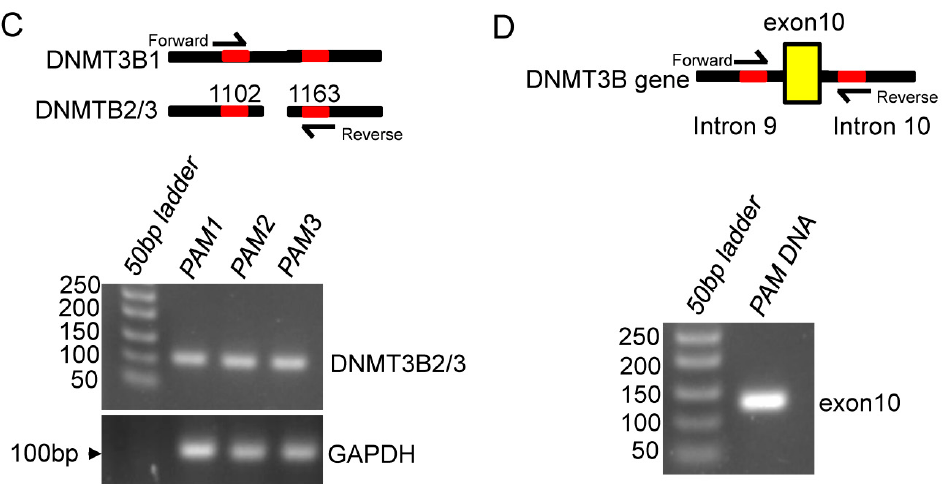
Figure 1. Identification of two splice variants of DNA methyltransferase 3B (DNMT3B) in porcine alveolar macrophages (PAM). ( A ) Schematic representation of the predicted DNMT3B1 and two splice variants identified in PAM. ( B ) Sequencing chromatogram showing the deleted region in the short splice variant named DNMT3B3 in comparison with the long splice variant named DNMT3B2. ( C ) Expression analysis of exon 10 of DNTM3B and GAPDH (about 90 bp) in PAM cDNA. Schematic representation of the exon 10-including fragment (about 160 bp) and the exon 10-excluded fragment (about 100 bp) from DNMT3B1 and DNMT3B2/3, respectively. Note that only a short fragment was obtained, indicating that expression of exon 10 of DNMT3B was absent in PAM. ( D ) As shown in the schematic, PCR was performed with an intron 9-forward primer and an intron 10-reverse primer to identify the presence of exon 10 (the positive fragment with 121 bp) in the genomic DNA from PAM. Note that a unique fragment was obtained, which was confirmed by sequencing analysis to show the presence of exon 10 in the DNMT3B gene of PAM.